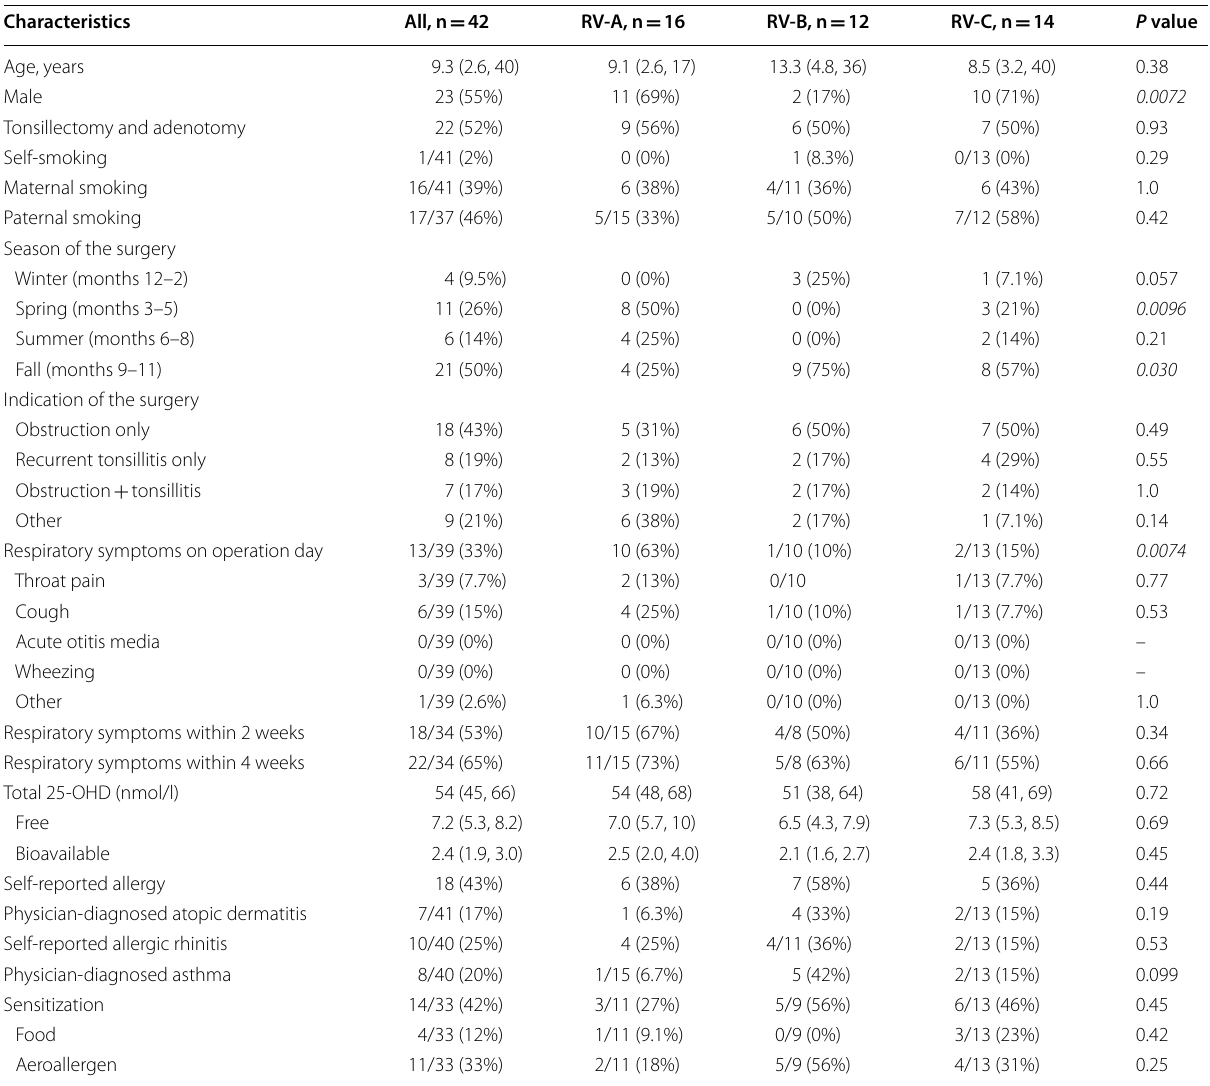
Table 1 Patient